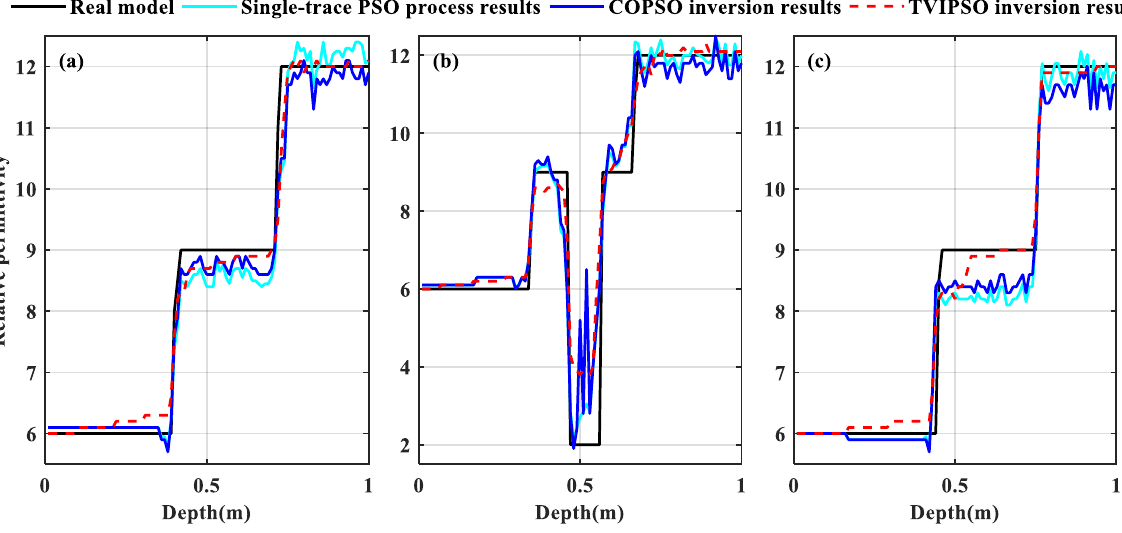
Figure 14. Comparison of dielectric permittivity inversion results at various distances: ( a ) 0.22 m; ( b ) 0.53 m; ( c ) 0.97 m.